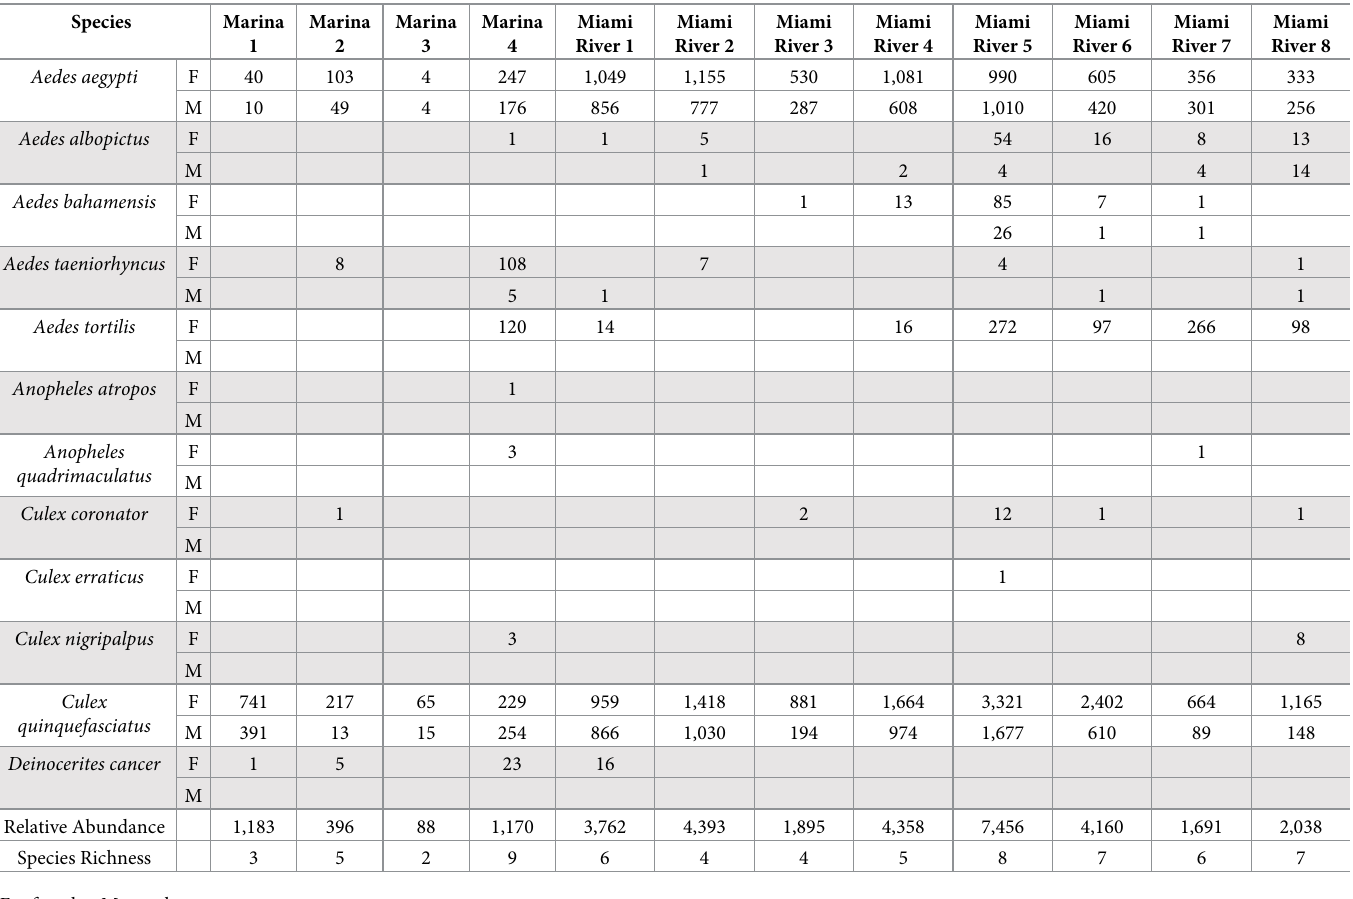
Table 1. Mosquitoes collected in 12 maritime ports of entry in Miami-Dade County, Florida.